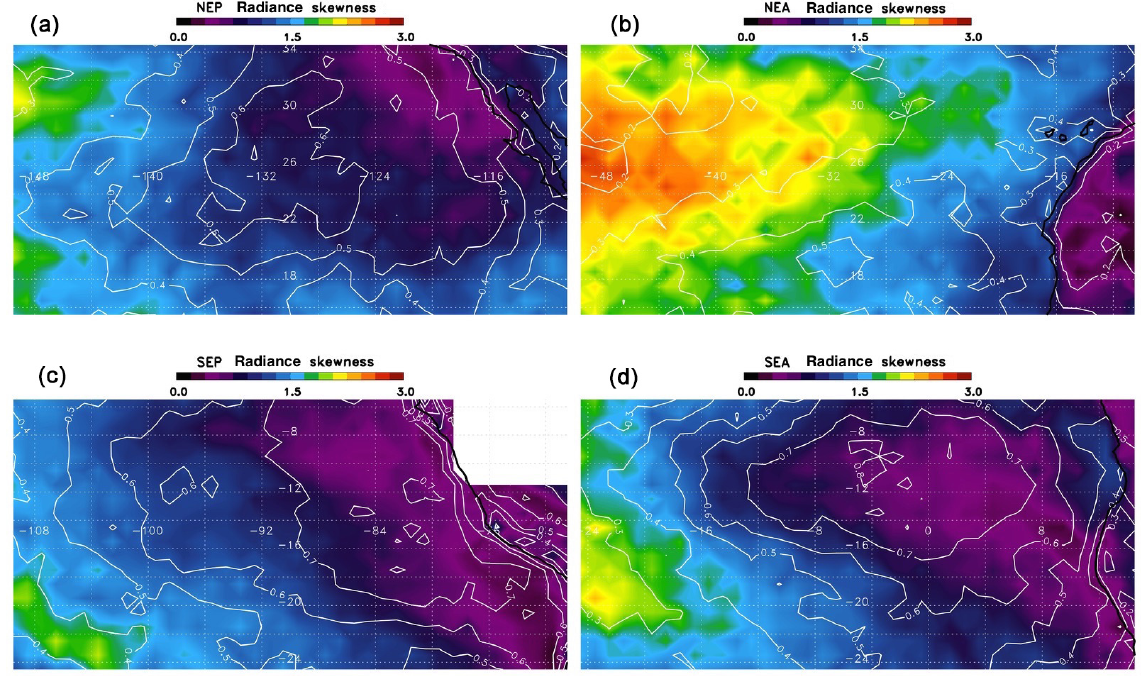
Figure 3. Radiance skewness for regions listed in Table 1: (a) NEP, (b) NEA, (c) , SEP, and (d) SEA. The AIRS ECF is overlaid as white contours.